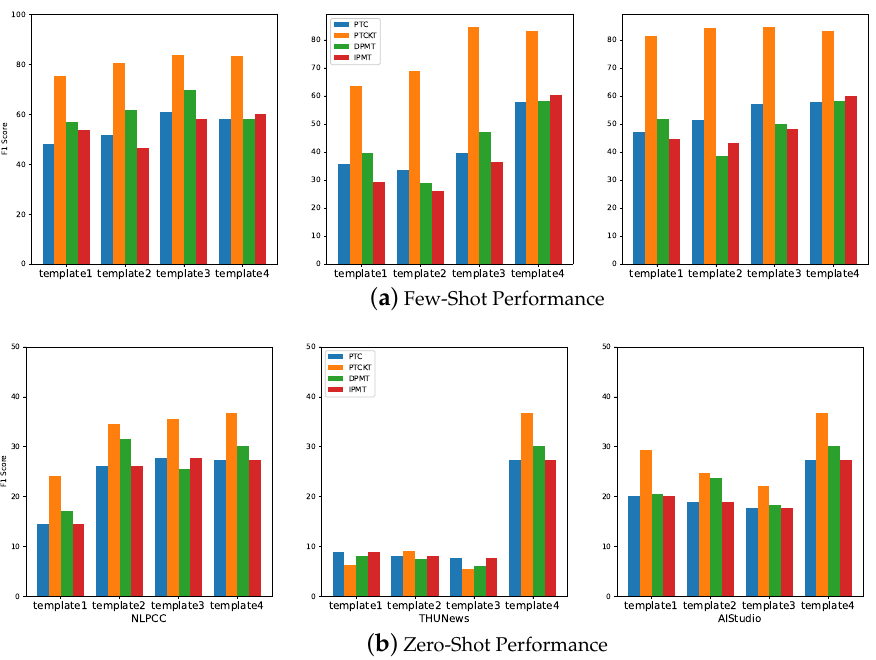
Figure 6. F1 score with different prompting templates.